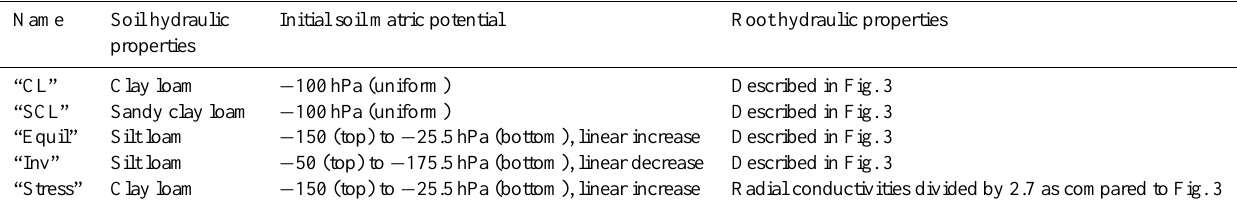
Table 1. Scenario names and